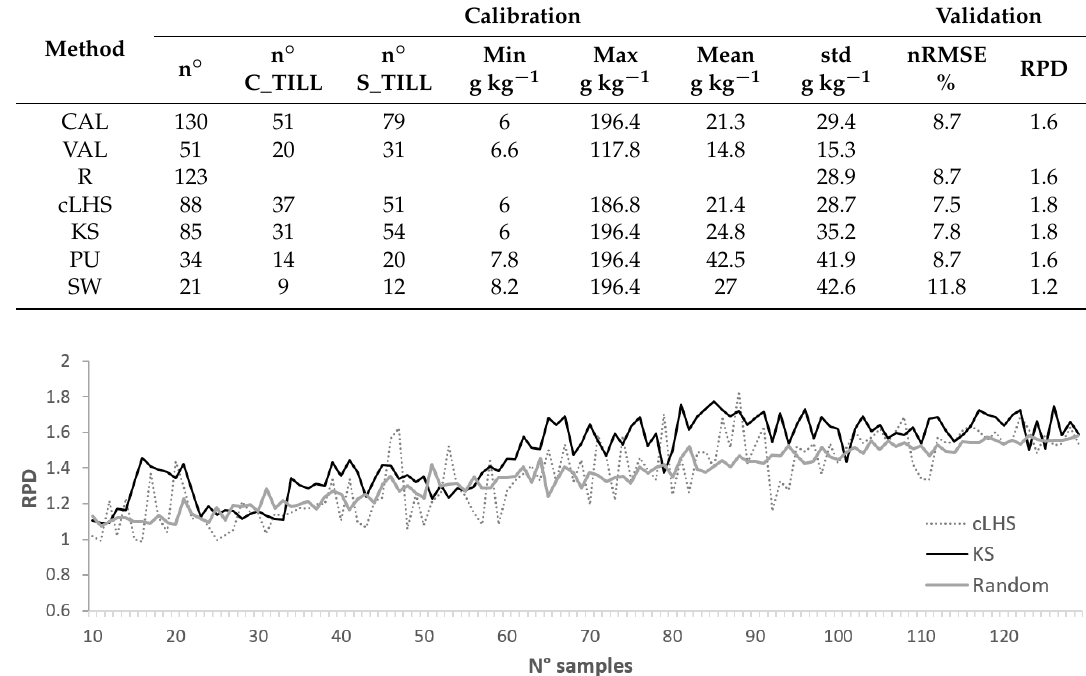
Figure 8. Ratio of performance to deviation obtained using from 10 to 129 samples detected by random selection, conditioned Latin hypercube (cLHS) and Kennard-Stones (KS) algorithms.